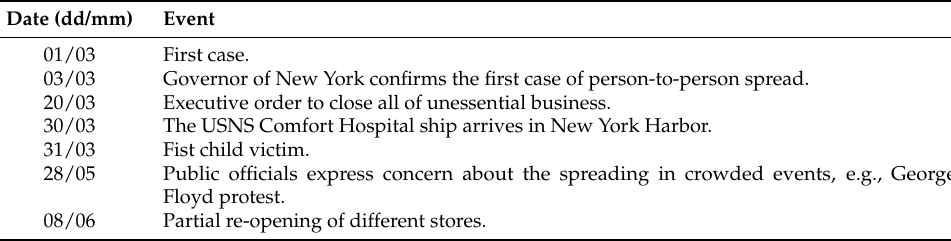
Table 9. Events and policies timeline related to the COVID-19 epidemic situation in New York